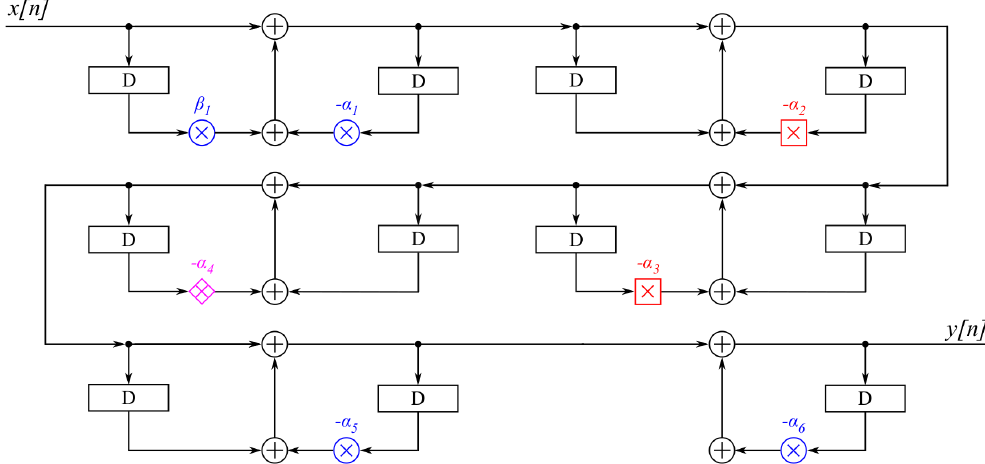
Figure 5. The proposed A-weighting filter. The ⊠ denotes the exact radix-4 multiplier, } denotes AO-RAD4 with M = 0, and ⊗ denotes AO-RAD4 with M = 5. α j and β j represent coefficients α 1 and β 1 of the j -th first-order sections